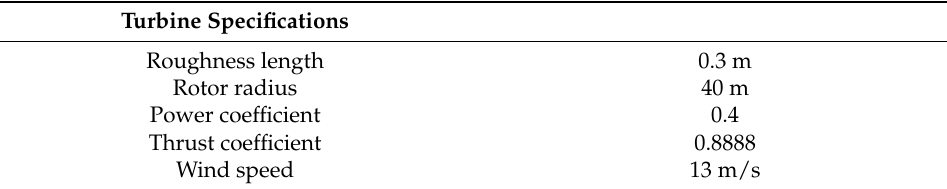
Table 2. The detailed specifications of wind turbines from the literature